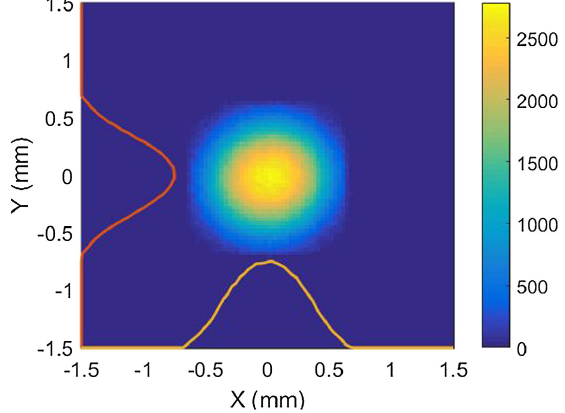
FIG. 10. A typical image in the momentum imaging measurements.